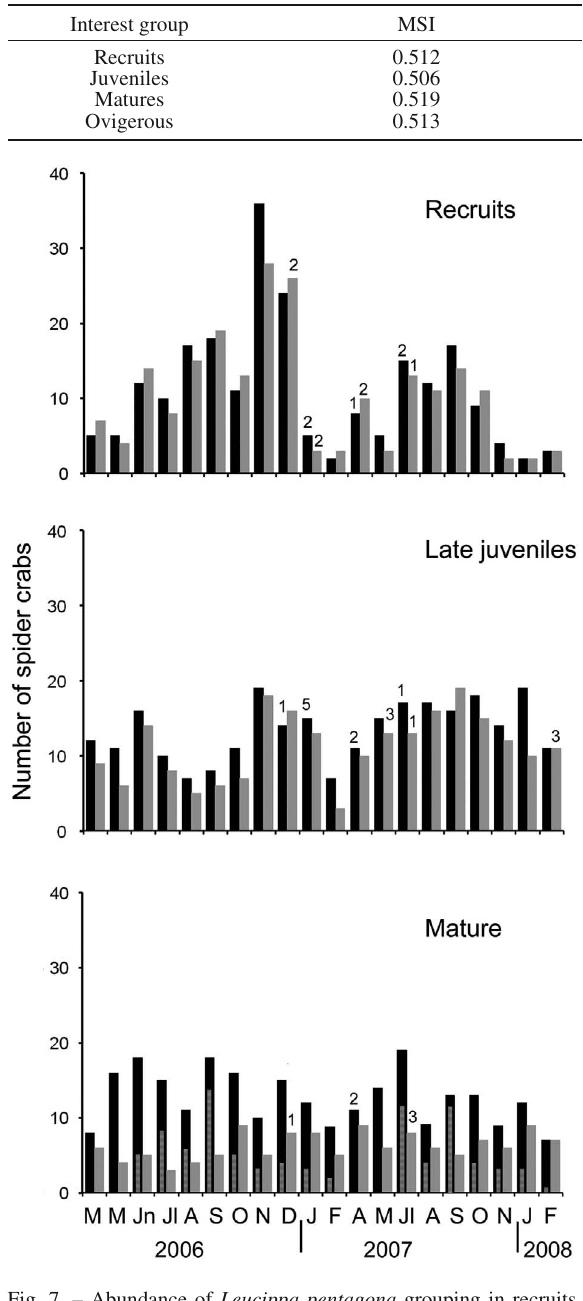
Fig. 7. – Abundance of Leucippa pentagona grouping in recruits, late juveniles and mature crabs. Female (black) and male (grey). Abundance of ovigerous females is indicated by a gray line for mature crabs. Numbers above the bars indicate the number of post- moult crabs.